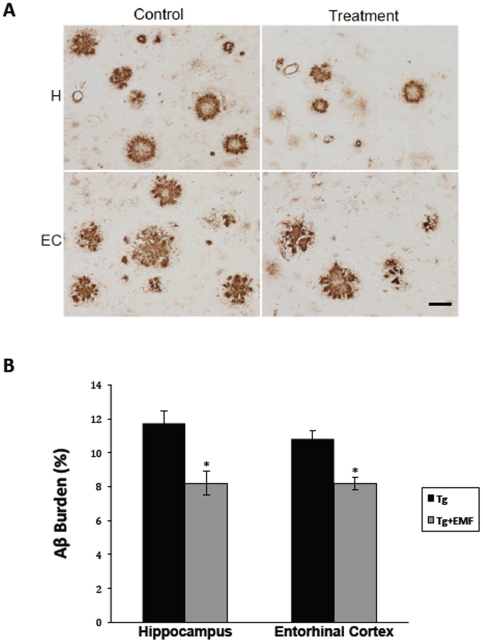
Brain Aβ deposition in APPsw transgenic (Tg) mice at 2 months after EMF treatment (Study I).(Fig. 6A) Photomicrographs showing the visually evident decrease in Aβ deposition in both hippocampus (H) and entorhinal cortex (EC) of EMF-treated mice compared to control/sham mice. Micrometer bar = 50 µm. (Fig. 6B) Quantification of percent Aβ burdens from EMF-treated and control/sham Tg mice. Highly significant reductions in Aβ deposition/aggregation were present in both hippocampus (↓30%) and entorhinal cortex (↓24%) of EMF-treated mice. *p<0.005 vs. Tg controls for that brain area.